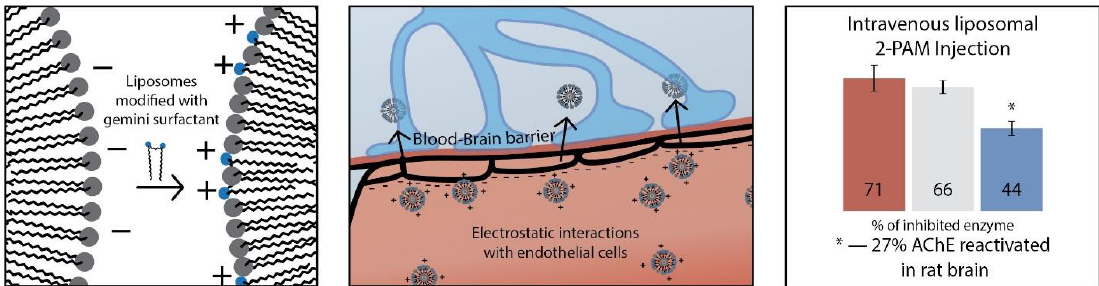
Figure 10. Electrostatic adsorption mediated transcytosis can be a mechanism to penetrate the BBB to reactivate brain AChE. Reprinted with permission from [216]. Copyright 2020